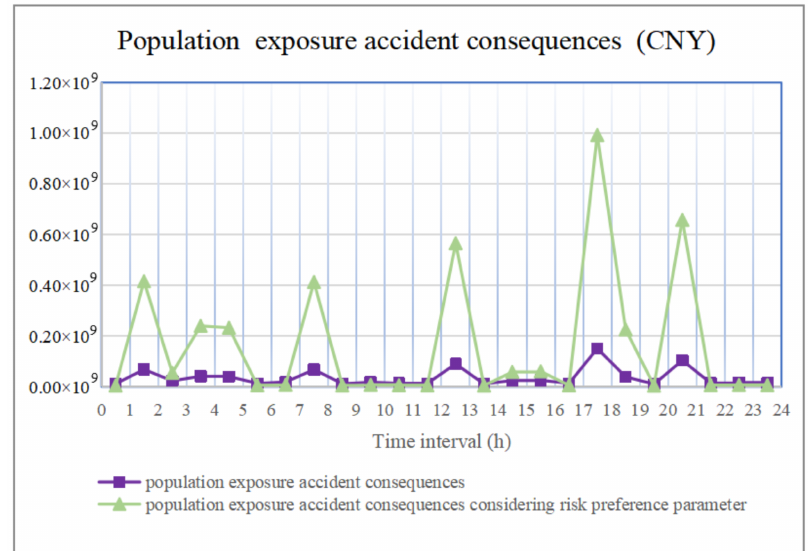
Figure 11. Population exposure accident